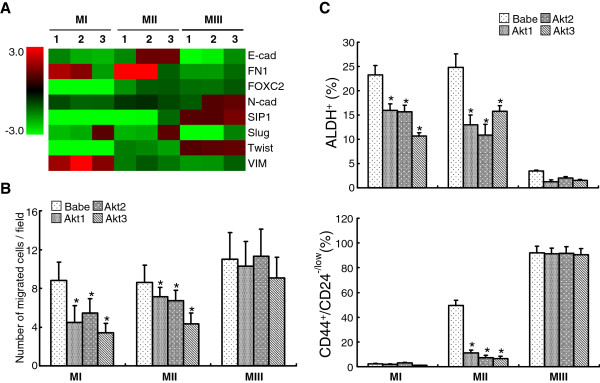
The inhibitory effects of Akt signaling on EMT, cell motility and stem/progenitor cell subfraction can be attenuated in cells that become progressively malignant. A. MI, MII and MIII cells were infected with retroviruses expressing vector control (Babe), Akt1 (1), Akt2 (2), or Akt3 (3), followed by RT-qPCR analysis for assessing expression levels of EMT-associated transcripts. Heatmap represents relative mRNA levels of various transcripts in Akt-expressing cells compared to the ones in control cells set as 1. B. Infected MI, MII, or MIII cells were tested for migration assay 12 hours after seeding on the top chamber of transwell plate and * denotes a significant change (p < 0.05) as compared to the control cells (Babe). C. Infected MI, MII or MIII cells were subjected to ALDEFLUOR staining (upper) or PE-CD24 plus FITC-CD44 double-staining (lower), followed by FACS analysis to quantify the frequency of ALDH+ and CD44+/high/CD24-/low subpopulations. * denotes significant (p < 0.05) difference between the Akt-expressing cells and the counterpart control.